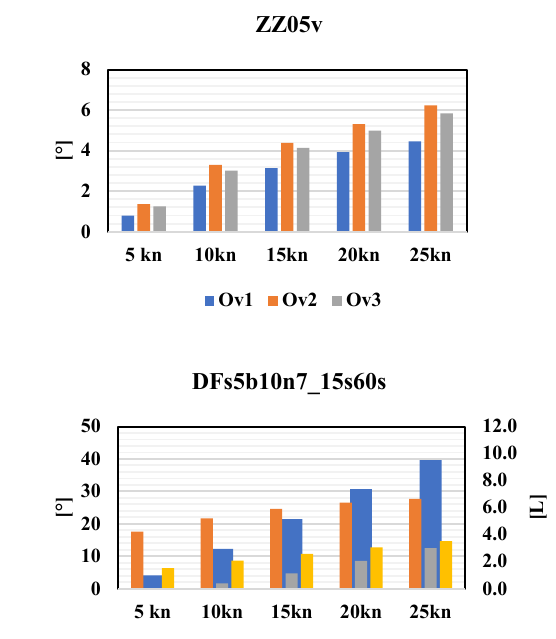
Figure 15. SMG x-Eq—Manoeuvring speed dependency.